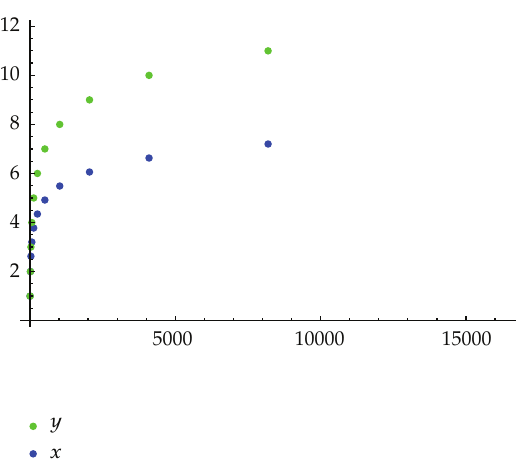
Figure 1: The graph of 10 iterates for the solutions of (cid:2) 4.20 (cid:4) and (cid:2) 4.22 (cid:4) illustrates the result of Theorem 4.4, here y (cid:2) t (cid:4) > x (cid:2) t (cid:4) for all t ∈ (cid:2) 1 , ∞ (cid:4) 2 Z